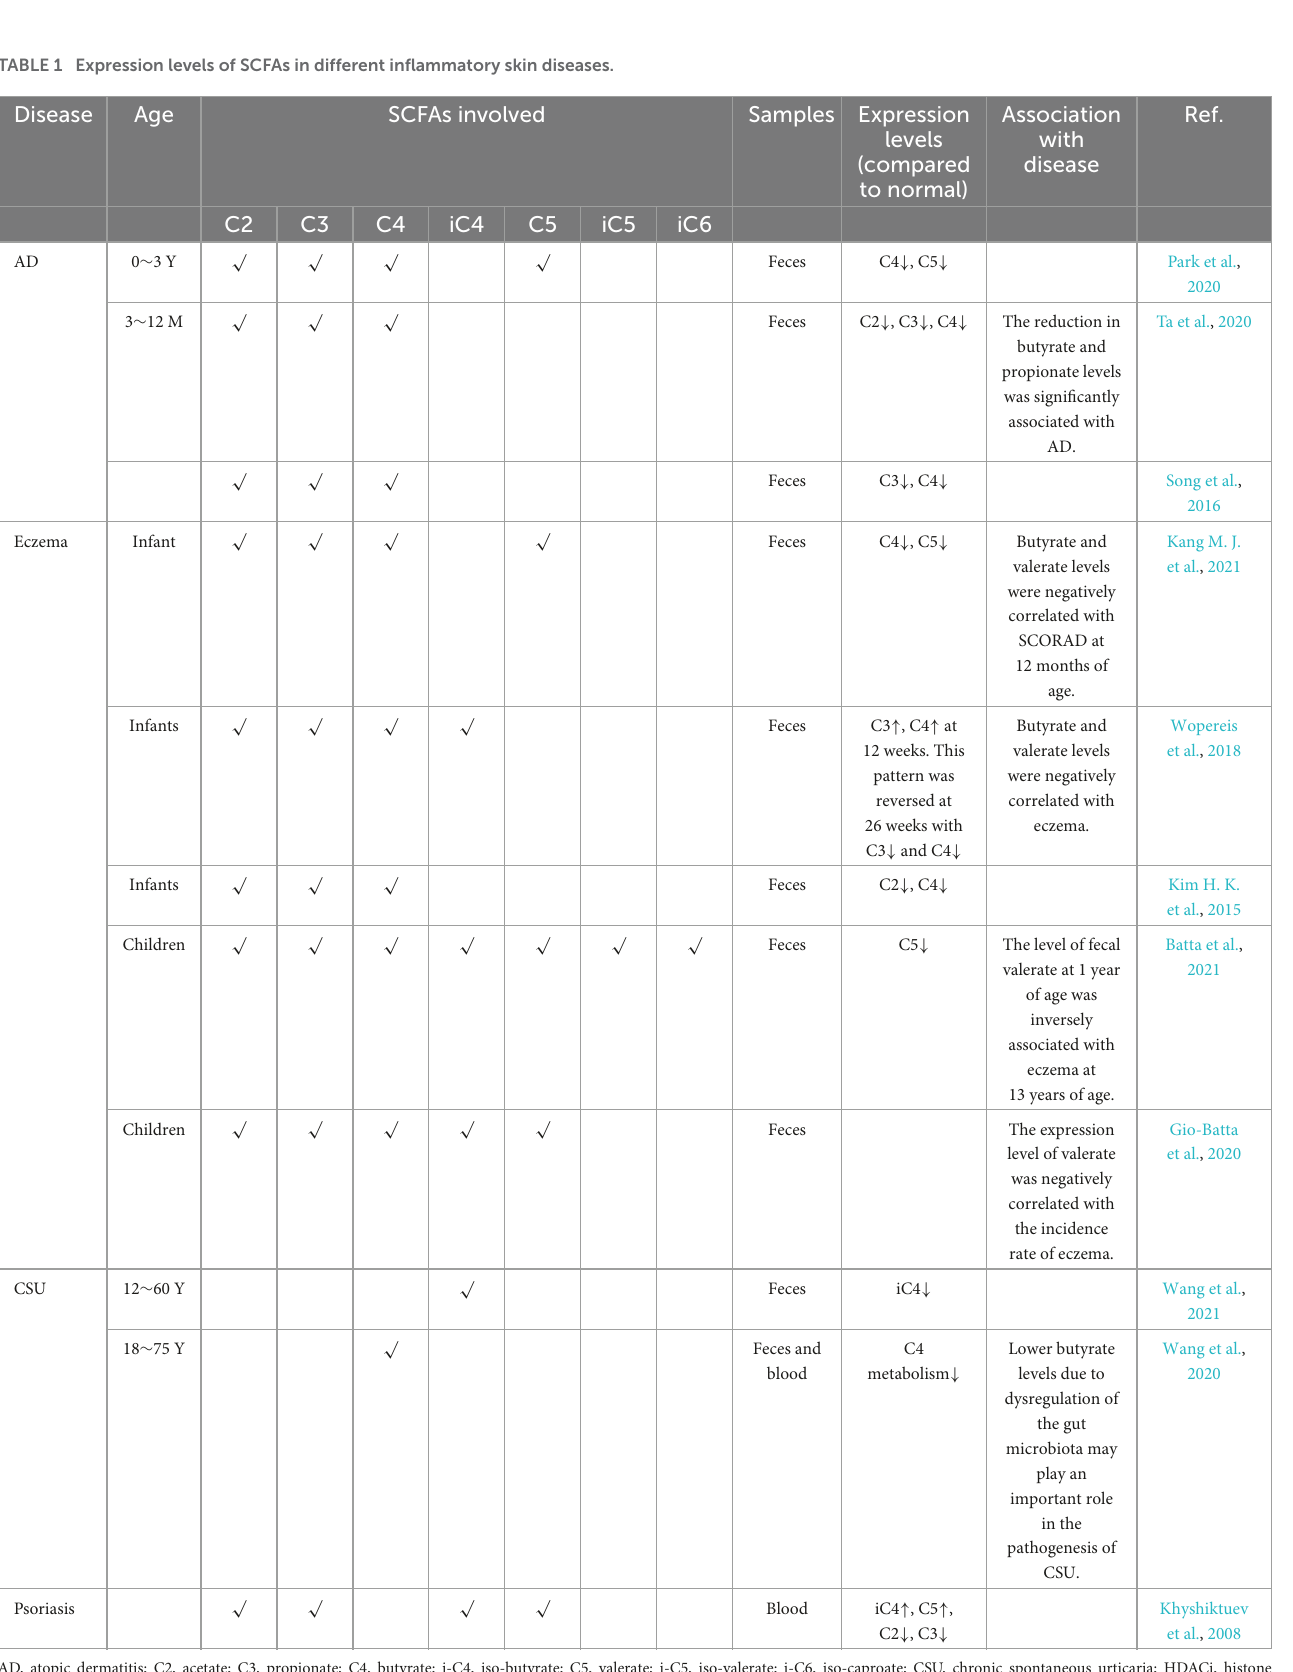
TABLE 1 Expression levels of SCFAs in different inflammatory skin diseases. Disease Age SCFAs involved Samples Expression